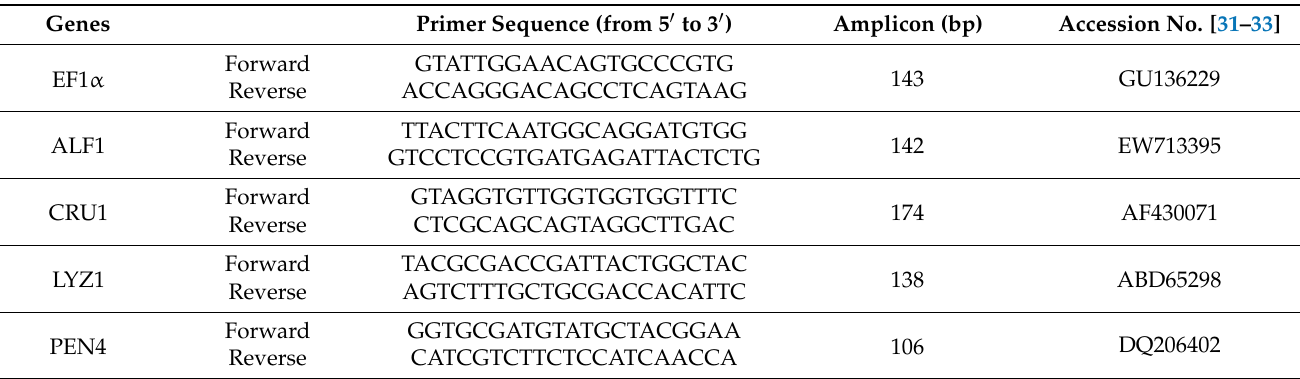
Table 1. Sequences of primer pairs used for analysis of gene expression by qRT-PCR. Primer Sequence (from 5 (cid:48) to 3 (cid:48) ) Amplicon